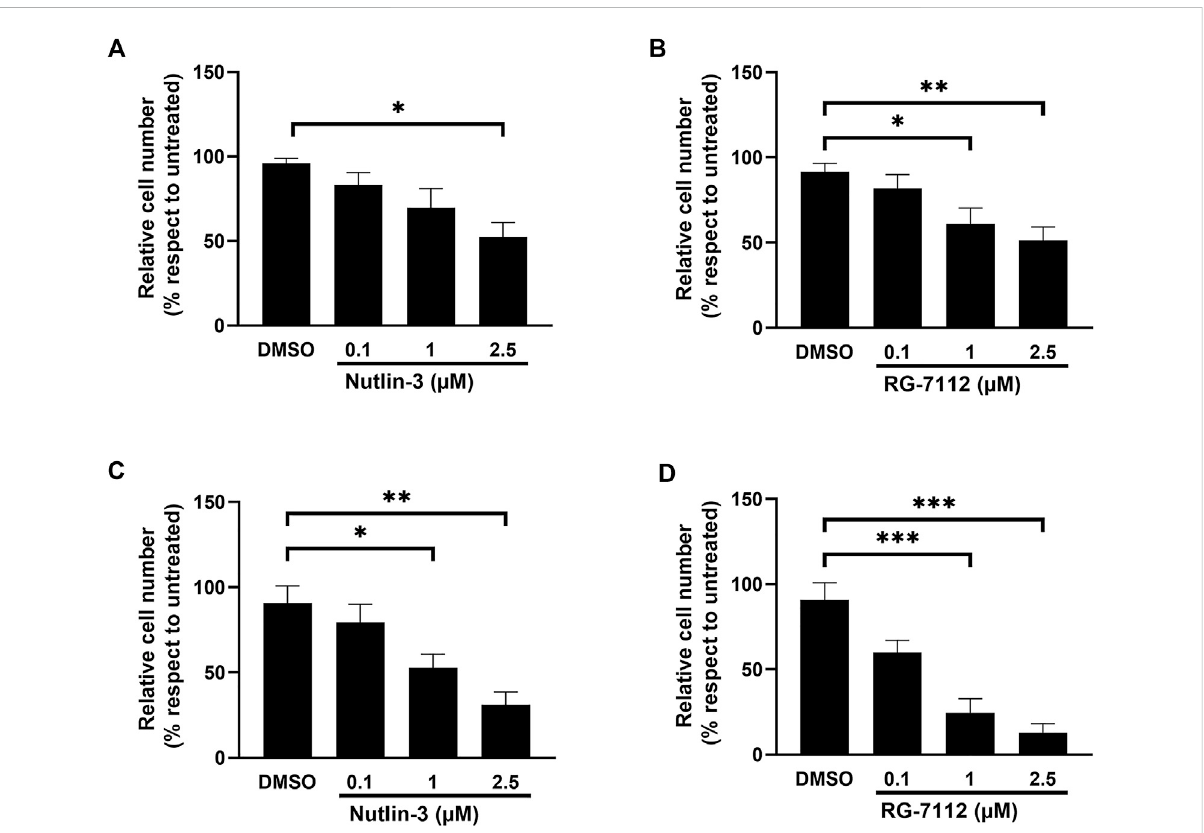
FIGURE 2 MDM2 inhibitors reduce alveolar basal epithelial cells proliferation. Cell growth analysis of A549-hACE2 cell cultures treated with different concentrations of Nutlin-3 (A,C) or RG-7112 (B,D) for 24 h (A,B) and 72 h (C,D) . Data are calculated as percentage with respect to untreated (set to 100%) and reported as mean ± standard error of the mean from three independent experiments. DMSO is reported as control vehicle. Statistical analysis was performed by ANOVA followed Bonferroni ’ s post hoc test. * p ≤ 0.05; ** p ≤ 0.01; *** p ≤